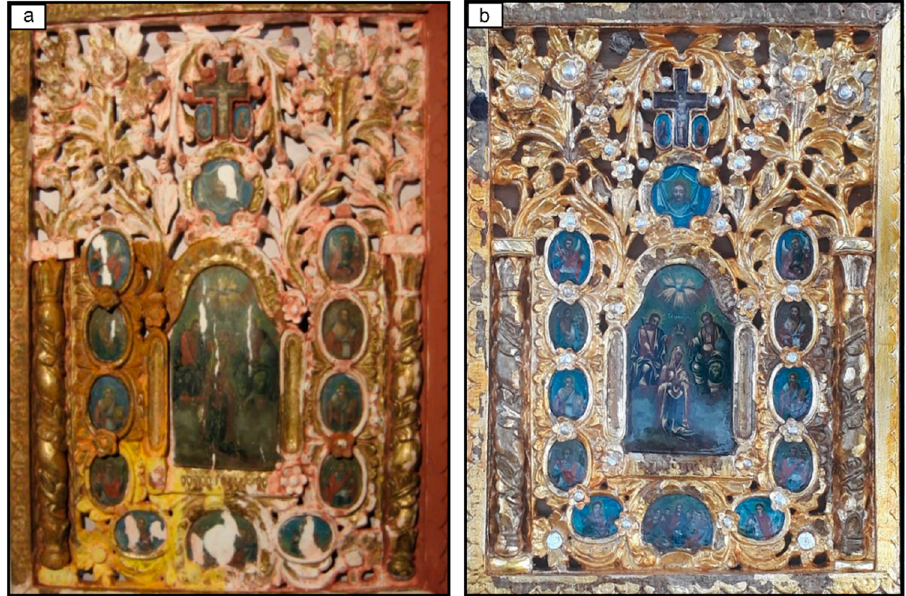
Figure 17. Final gilding reintegration in tratteggio technique: ( a ) Final cleaning and grouting of the lacunar areas with materials compatible with the preparation; ( b ) Revarnishing with partial repatination over the reintegration by gilding and the tratteggio technique of the painted areas.